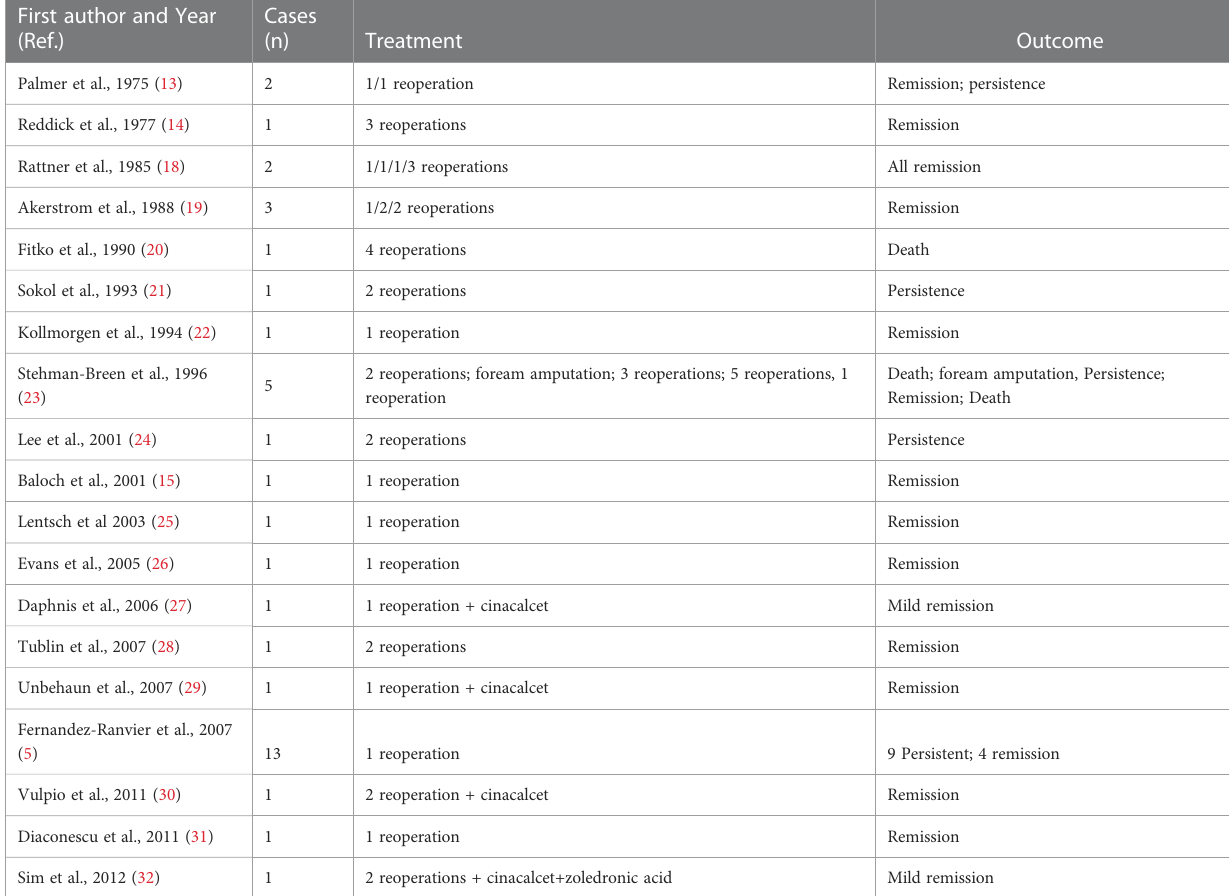
TABLE 2 Parathyromatosis: review of